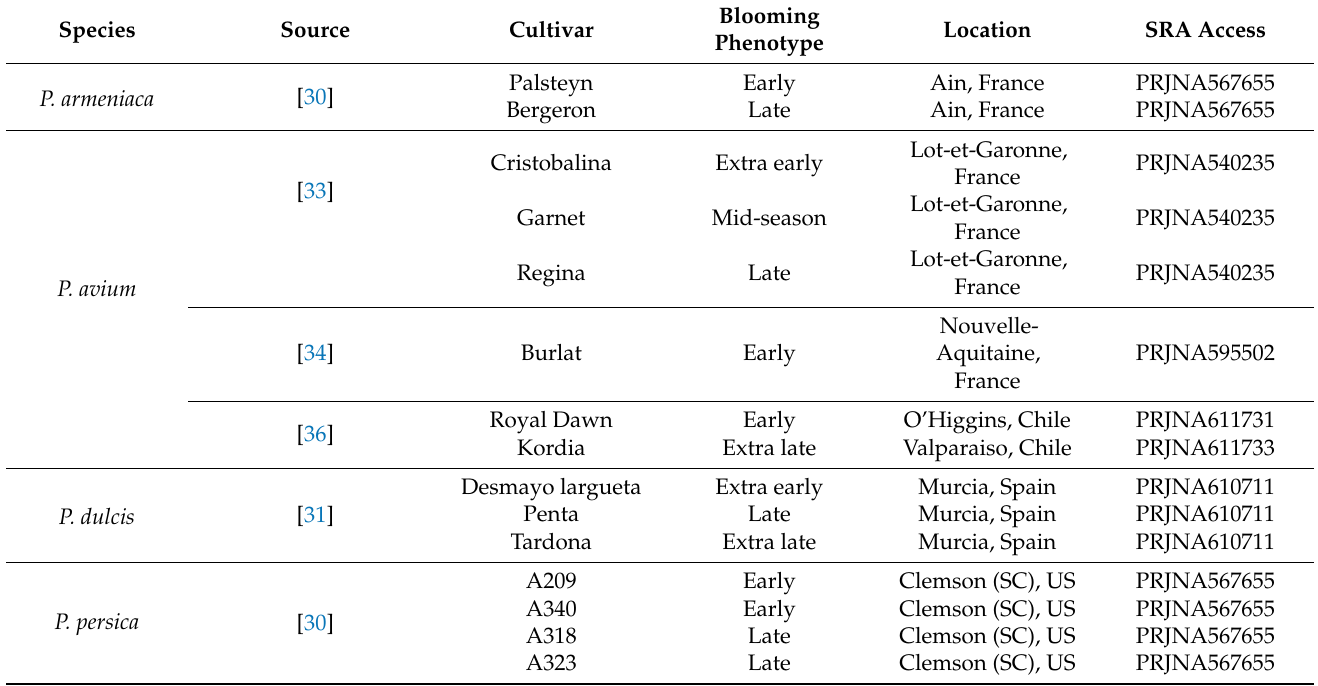
Table 1. Summary of metadata included in the